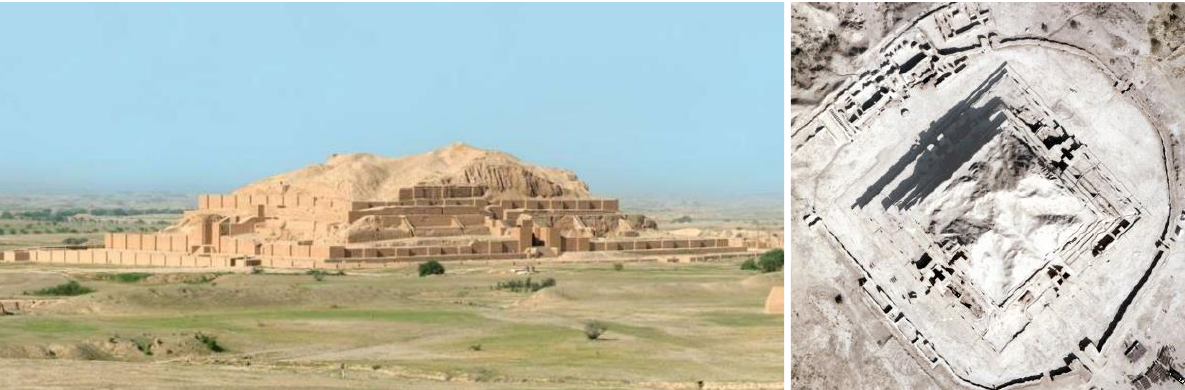
Figure 1. The ziggurat of Tchogha Zanbil World Heritage site and its aerial photo (Archive of Tchogha Zanbil center).